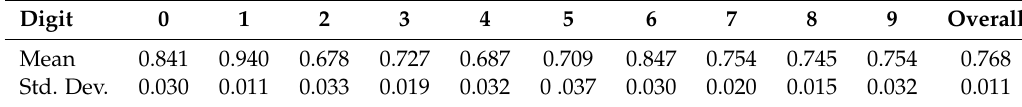
Table 2. Summary of F 1 scores on a 10-fold cross validation.